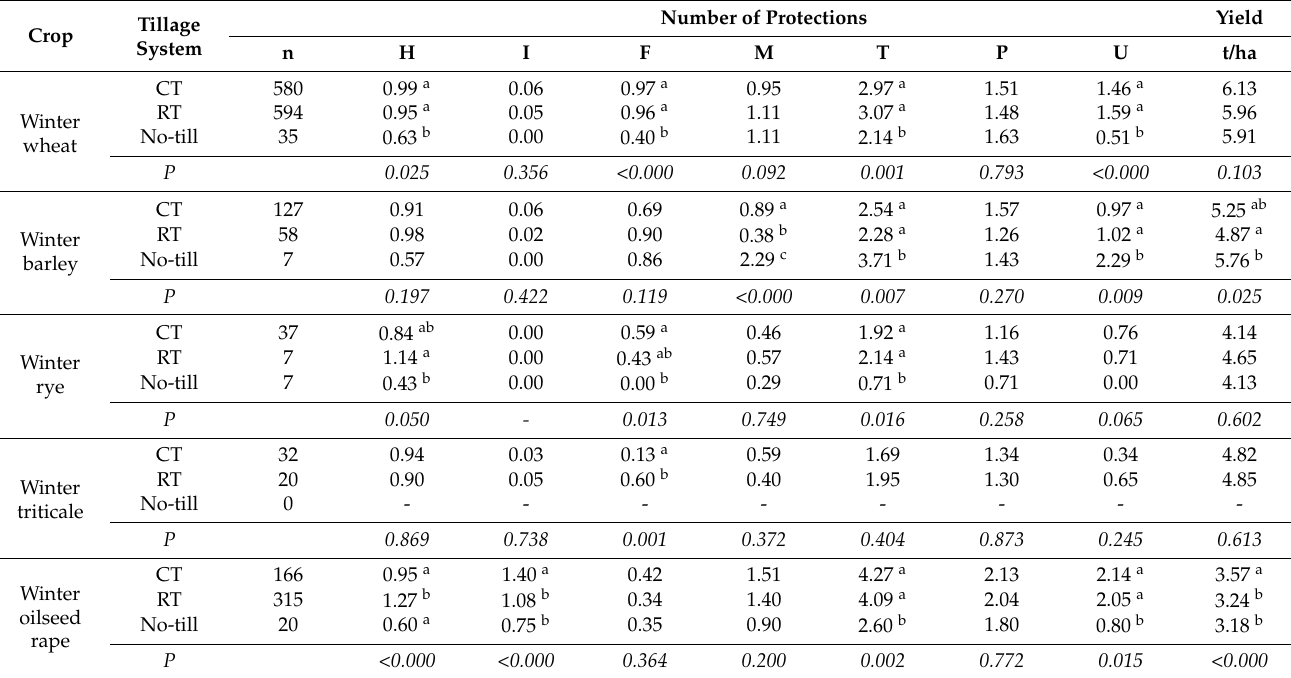
Table A11. Number of chemical protections of evaluated winter crops cultivated at different tillage systems; average of years 2002–2010.